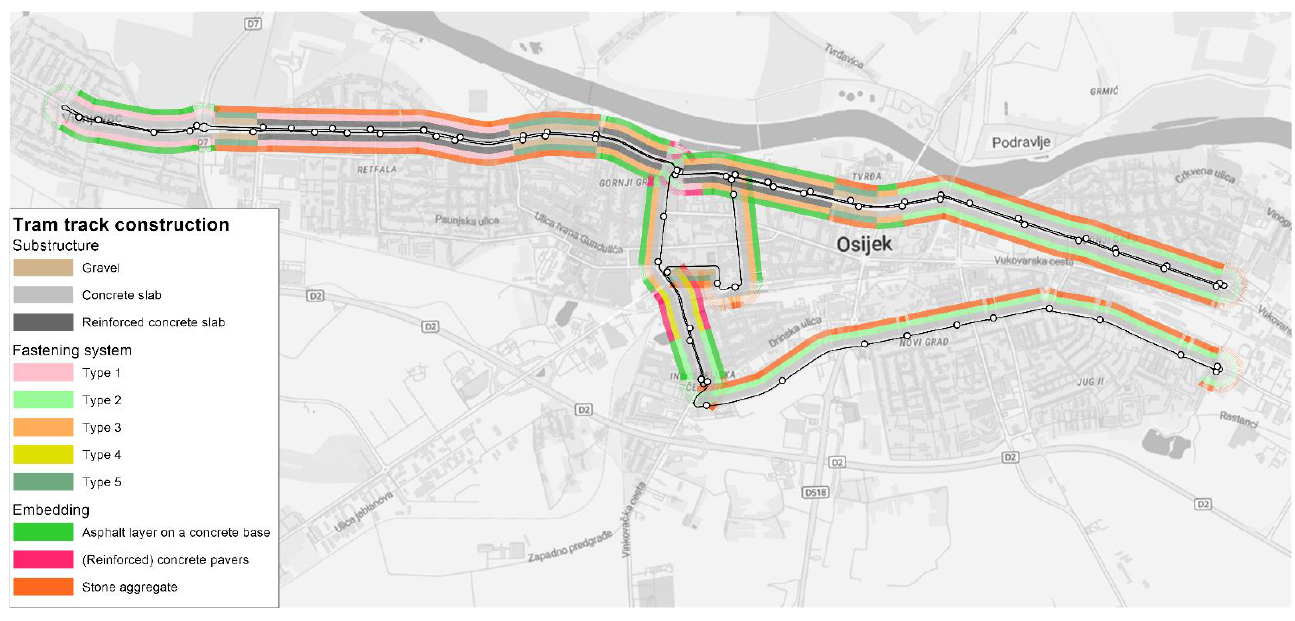
Figure 1. The City of Osijek tram lines 1 and 2 and cumulative track exploitation intensity.